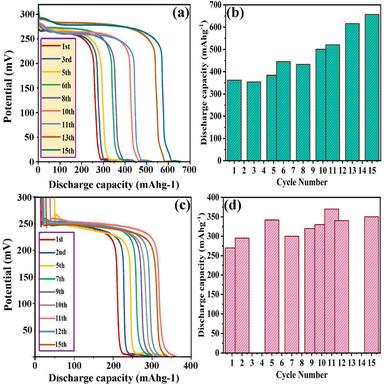
Discharge profiles and cycles discharge capacity profiles of (a, b): S5 and (c, d) S7.